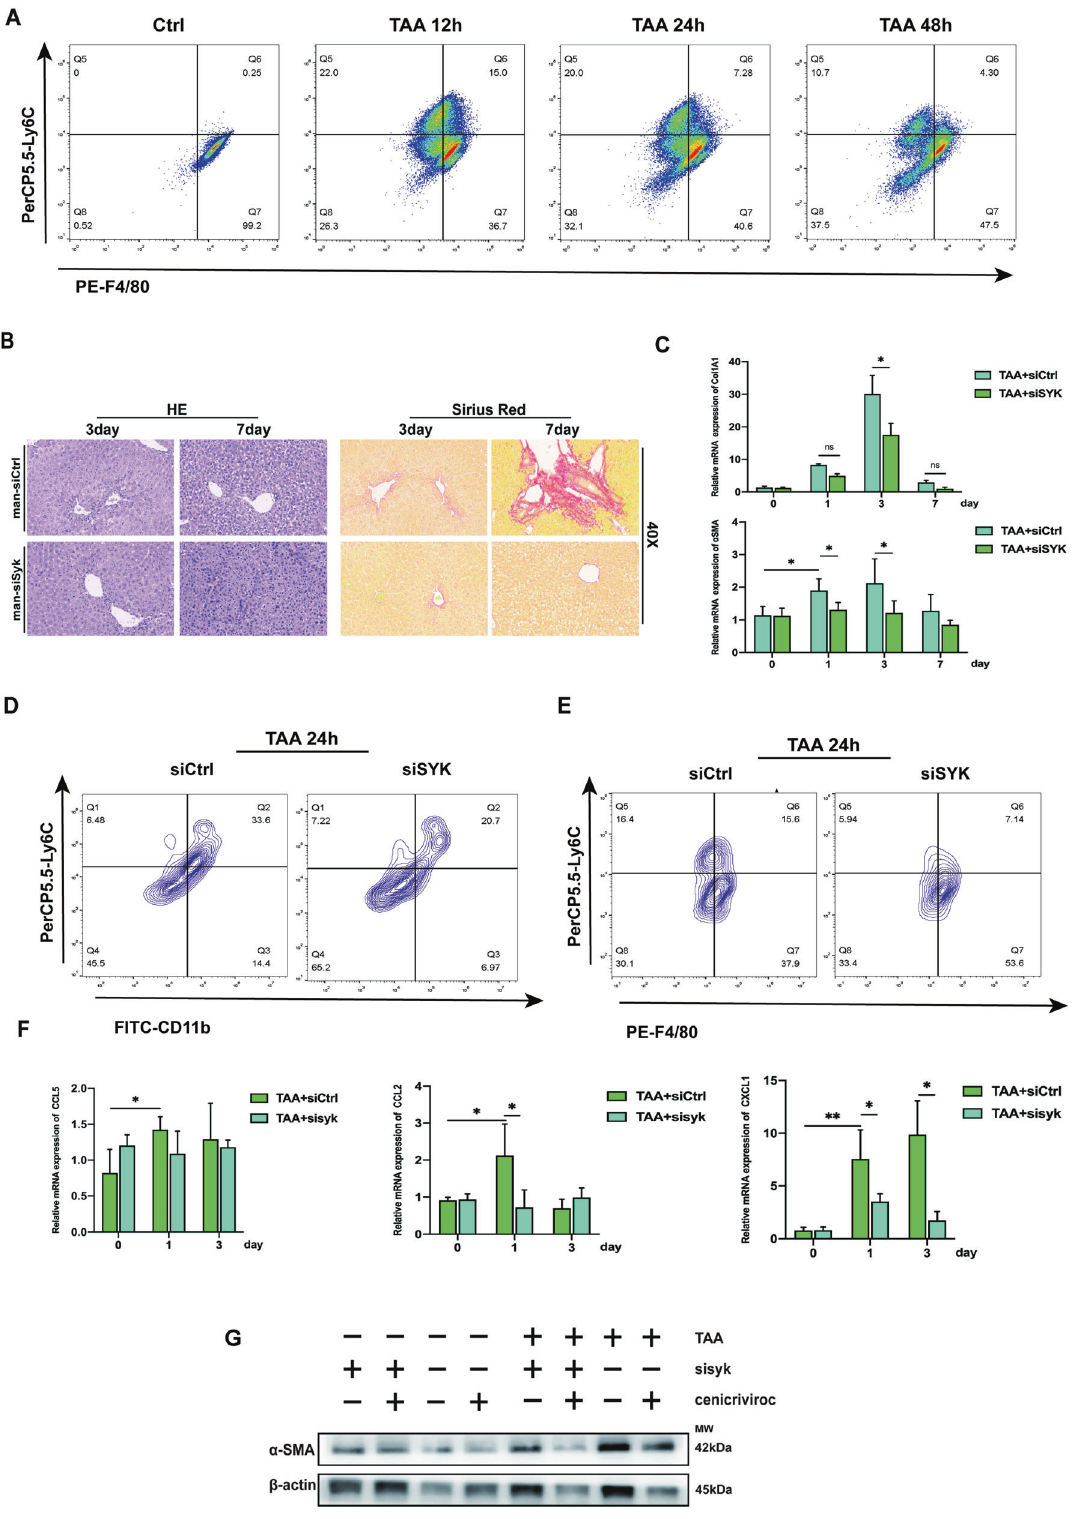
Fig. 5 Blocking MoMFs SYK reduced the recruitments of Ly6C hi macrophages and the production of CXCL1. A 12 h, 24 h, 48 h after the subacute lethal dose of TAA in mice, F4/80 and Ly6C expression were used to de fi ne the phenotypic transition pattern of macrophages. B On the 3rd and 7th day after TAA injection, HE and Sirius Red were induced to detect liver fi brosis. C mRNA levels of Col1A1, α SMA, in the liver at 1, 3, and 7 days after TAA injection; D , E Mice were injected with siCtrl or siSYK via tail vein 4 h before TAA injection. Flow cytometry analysis of the expression of CD11b, Ly6C and F4/80 in liver nonparenchymal cells. F mRNA levels of CCL5, CCL2, and CXCL1 in the liver at 1 and 3 days after TAA injection; G 24 h after TAA injection, the protein level of α SMA in different treatment groups was detected.